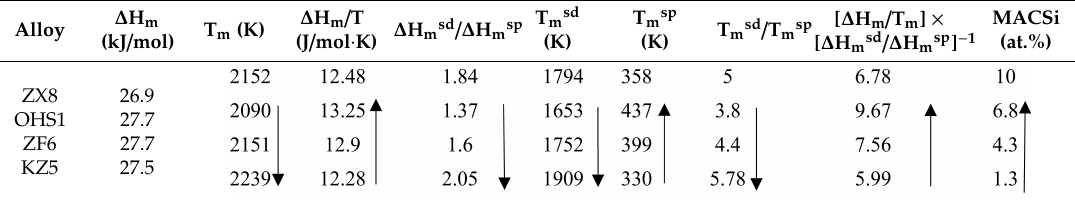
Table 4. Alloy parameters for the macrosegregation of Si (MACSi) in the cast alloys KZ5, ZF6, OHS1, and ZX8.